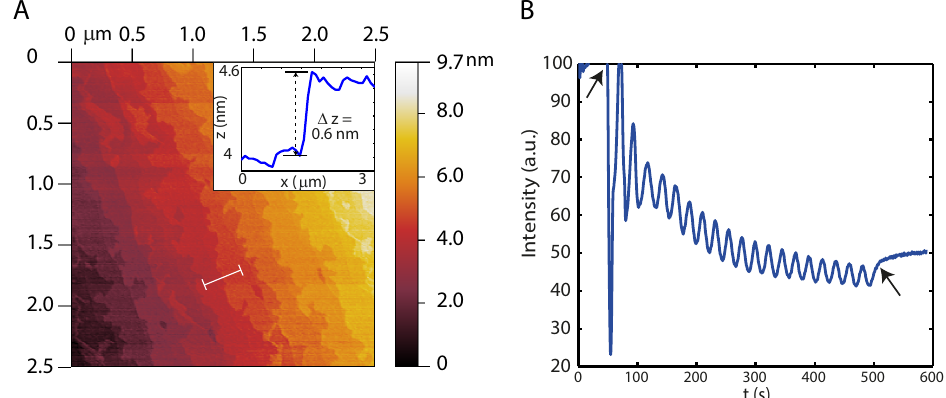
Figure 5. ( A ) Example of an atomic force microscopy (AFM) image of an annealed LaSrAlO substrate (1050 C, 10 h) showing clear steps. The inset shows the height profile of one step, indicating the step height is half a UC. This is due to the double termination of the substrate UC. The rms roughness is 0.23 nm; ( B ) Graph of Refractive High Energy Electron Diffraction (RHEED) intensity vs. time which shows the oscillations of the specular reflected beam for the growth of a 10 UC thick La Sr CuO (Sr doping is 0.05) on LaSrAlO . The oscillations are typically preserved up to the 1.95 0.05 4 4 20th RHEED oscillation and are indicative of layer-by-layer growth of the cuprate. The arrows indicate the start and end of the deposition